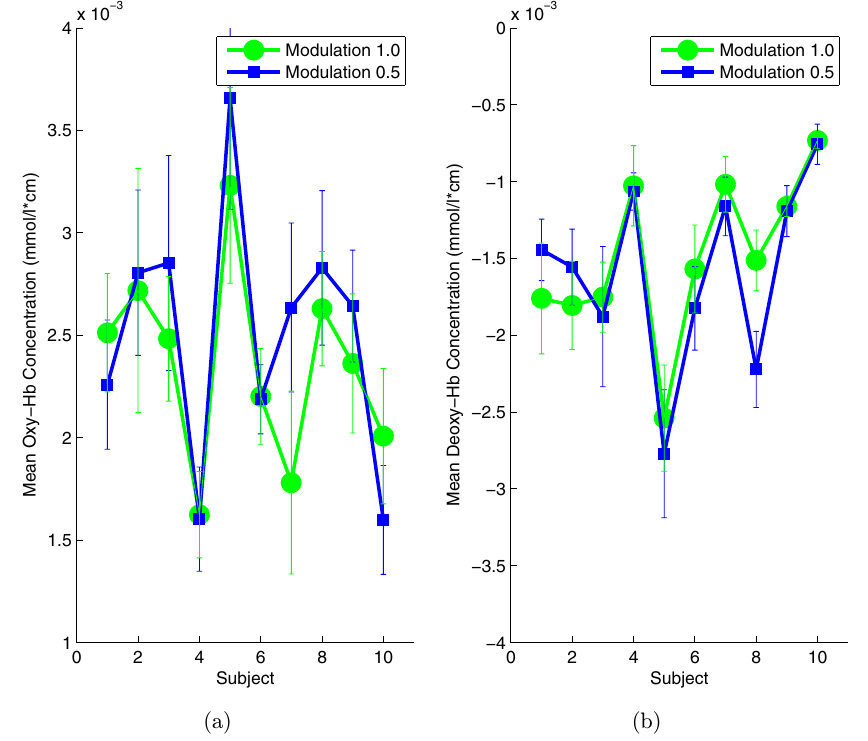
Fig. 9. Hemodynamic responses of the visual cortex to the two modulations depths of the °ickering stimuli. (a) Oxy-Hb con- centration and (b) Deoxy-Hb